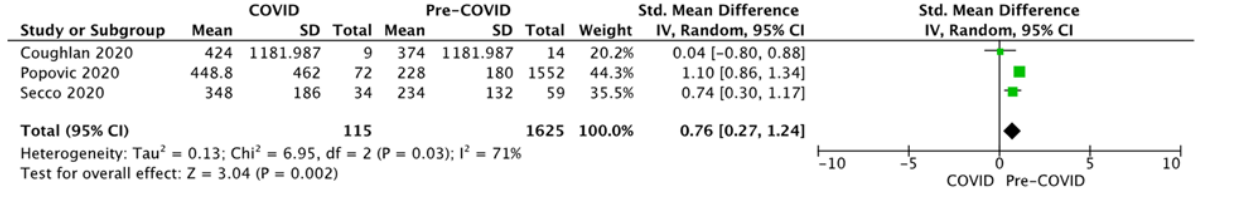
Figure 5. Forest plots for total ischemic time.